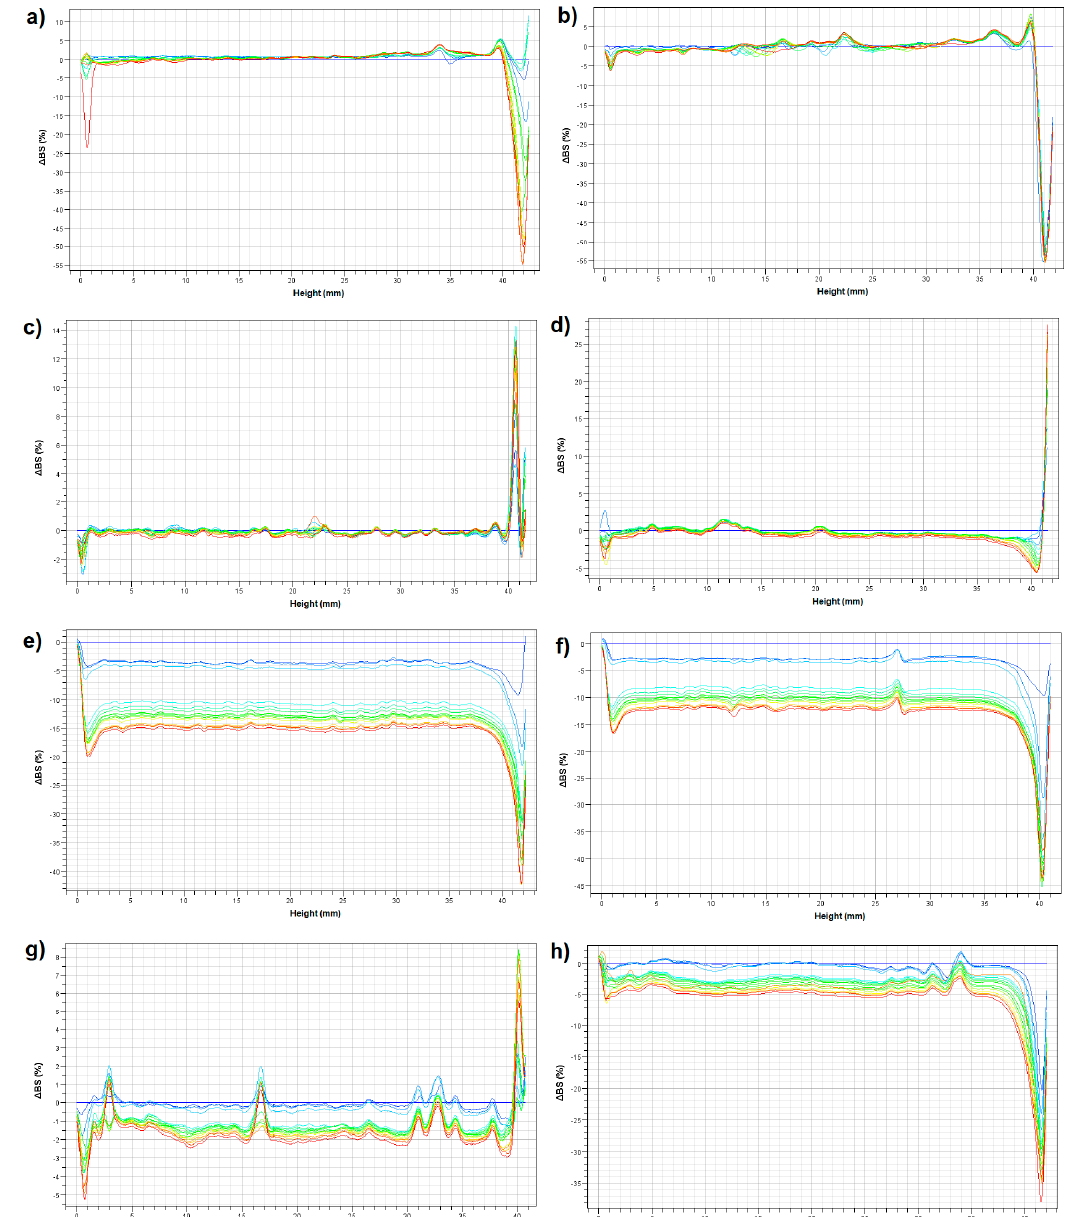
Figure 4. Backscattered light intensity profiles of the prepared emulsions in reference mode. ( a ) E1,